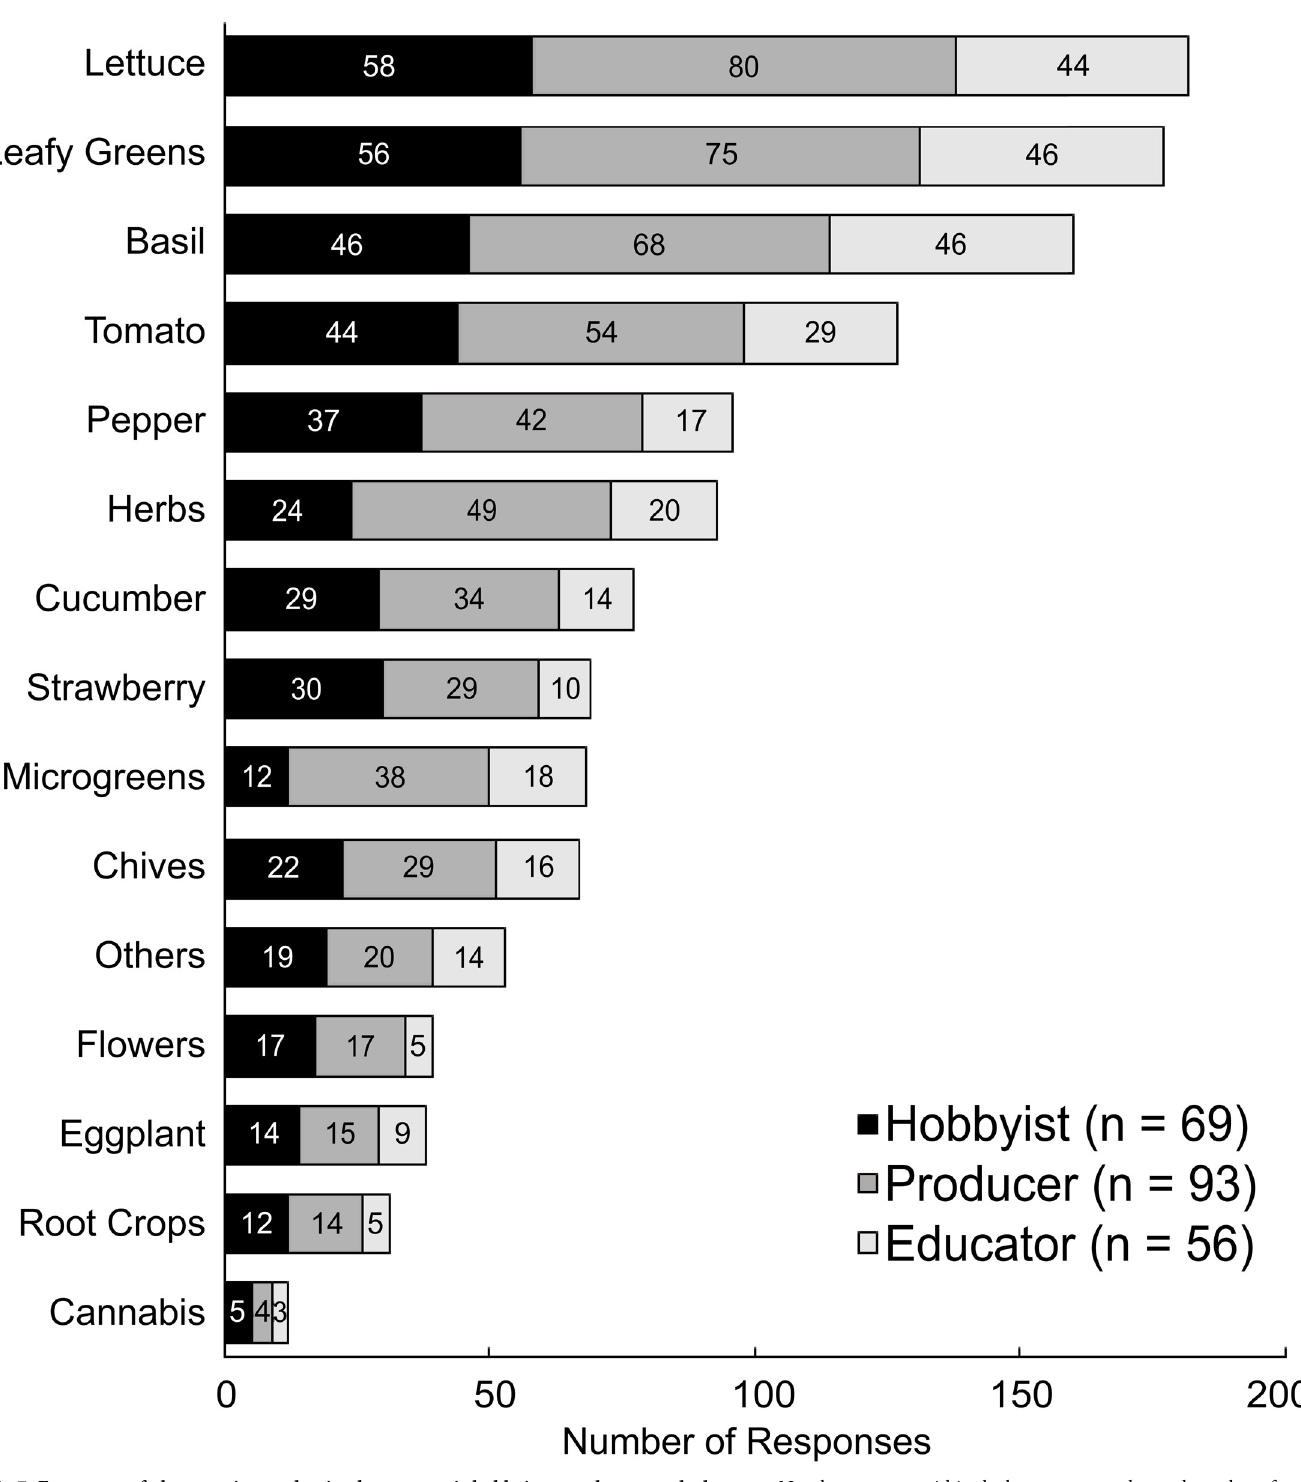
Fig 7. Frequency of plant species production by aquaponic hobbyists, producers, and educators. Numbers present within the bars represent the total number of selections made by each stakeholder group. Note—“Other” crops grown by participants included aloe, banana, bay tree, beans, bok/pak choi, brewer’s hops, broccoli, cauliflower, celery, cherry tomato, chili pepper, corn, cilantro, duckweed, edible flowers, ginger, green beans, kale, luffa, mango, medicinal herbs, melons, mint, Momordica charantia, okra, papaya, parsley, peanuts, peas, pineapple, pumpkins, raspberry, rosemary, squash, stevia, Swiss chard, turmeric, ulva, water lilies, watercress, and